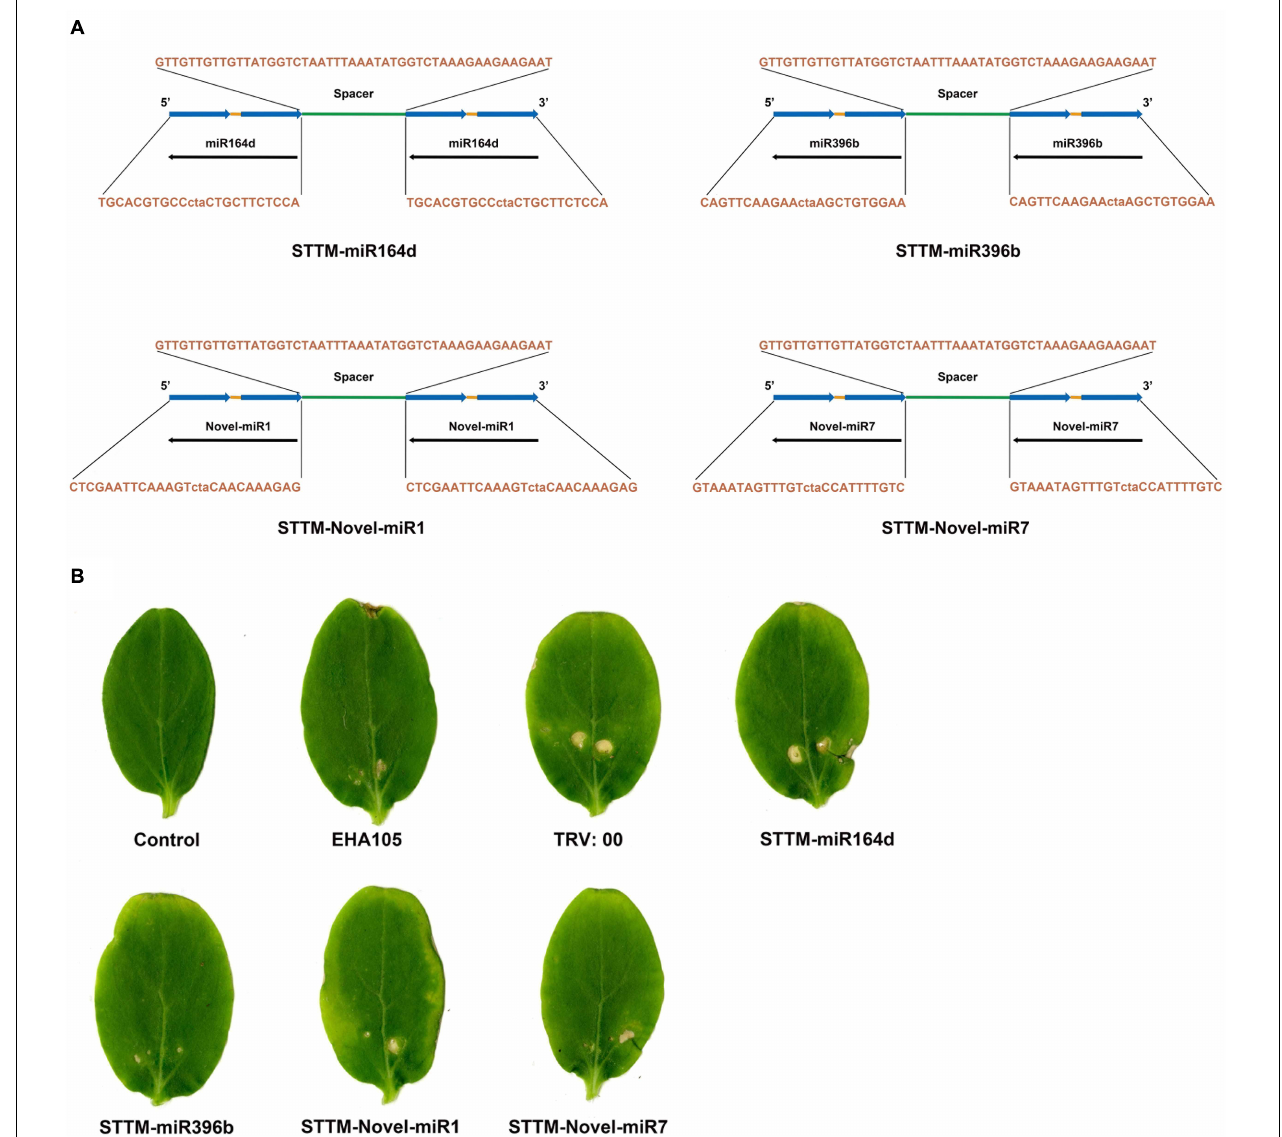
FIGURE 5 | TRV induced STTM-miRNA silencing. (A) Diagram of STTM. (B) Symptoms in cucumber cotyledons following TRV-induced genes